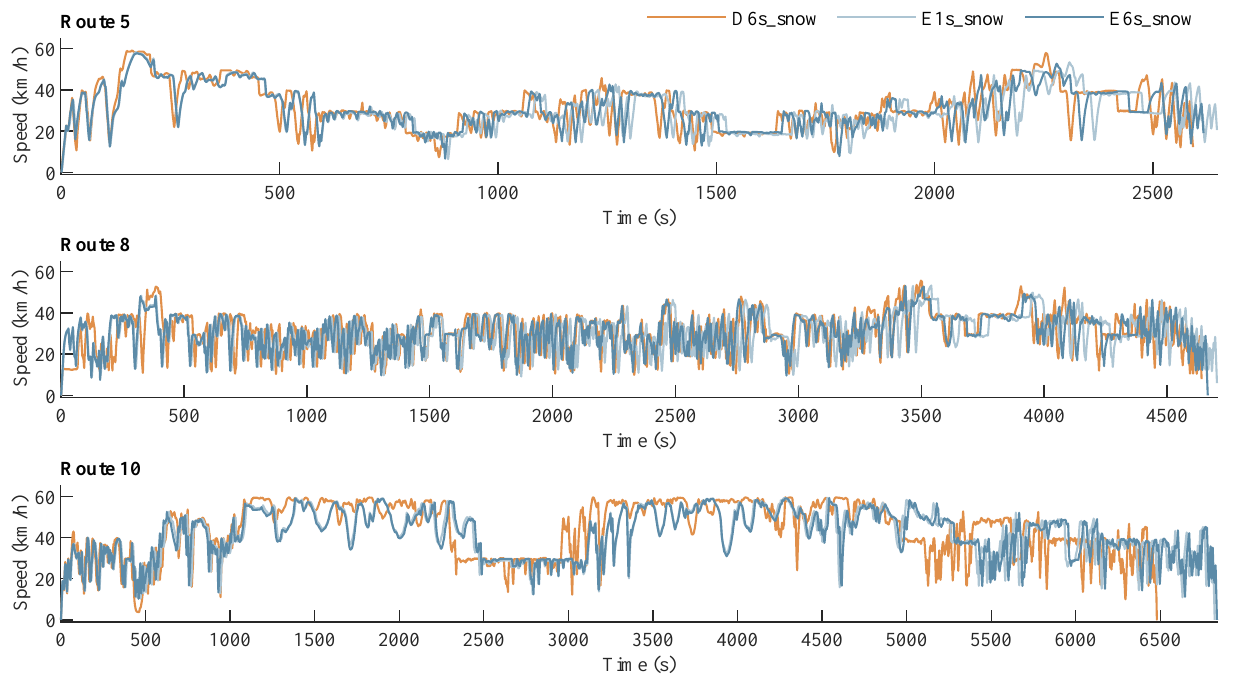
Figure 12. Simulated speeds of three vehicle types with the snow load on routes 5, 8, and 10. Figure 13 compares the time taken to drive each of the routes. As Figure 11 already indicated, differences in the total driving durations between the three powertrain types with the cargo profile are rather subtle. With the snow load the diesel version is consistently the fastest while the electric multi-speed and electric single-speed version come in the second and third. Nonetheless, even the biggest difference of about 6 minutes on Route 10 between D6s_snow and E1s_snow profiles alone would not be a bottle neck in this type of work case.